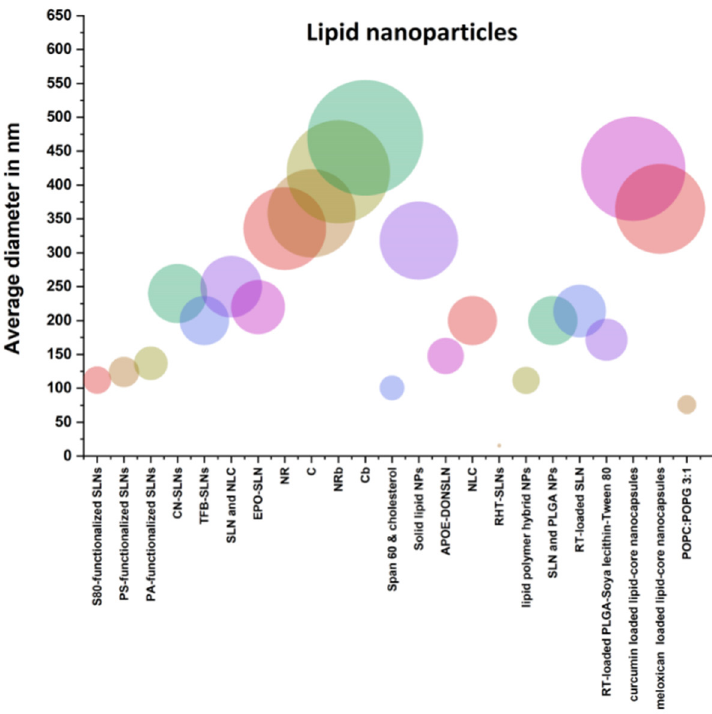
Figure 6. Different sizes of lipid nanoparticles used in AD treatment. Polymers 2021 , 13 , x FOR PEER REVIEW